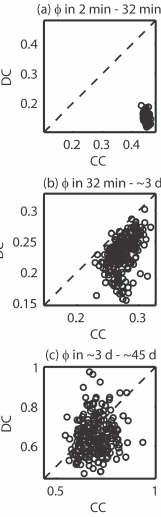
Fig. 10. Scatter plots between the intermittency exponents com- puted for the signal sampled with CC (x-axis) and DC (y-axis) methods. Panels (a) – (c) and (d–f) refer to µ BS scaling regimes.